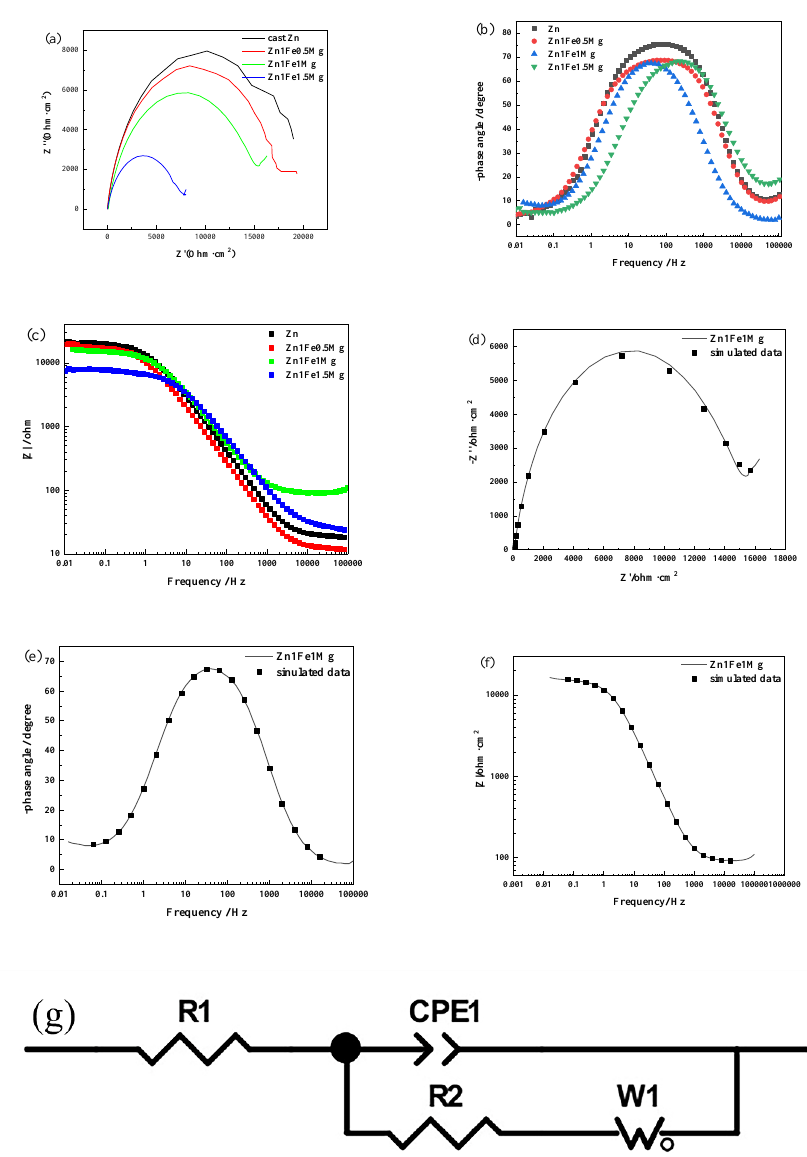
Figure 6. Electrochemical impedance spectroscopy (EIS) spectra of Zn-Fe-Mg in SBF solution at room temperature: ( a ) Nyquist diagram comparison and simulated results of the Zn-Fe-Mg alloy: ( b ) Bode phase angle diagram; ( c ) Bode impedance–frequency diagram; ( d – f ) Nyquist diagram, phase angle diagram, and impedance-frequency diagram of Zn1Fe1Mg and simulated data; ( g ) The equivalent circuit of EIS spectra for the Zn-1Fe-Mg alloy: R1 is the solution resistance; CPE1 is constant phase angle element; R2 is the charge-transfer resistance; W1 is the Warburg finite-length diffusion impedance.